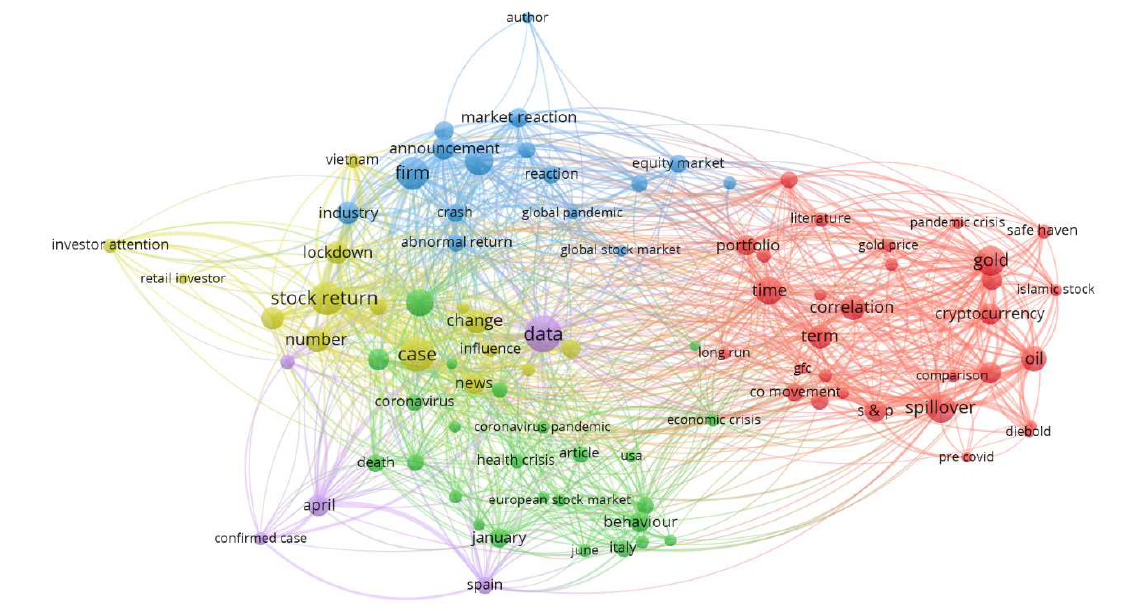
Figure 3. Network visualization on the Scopus database of “The stock market throughout the COVID-19